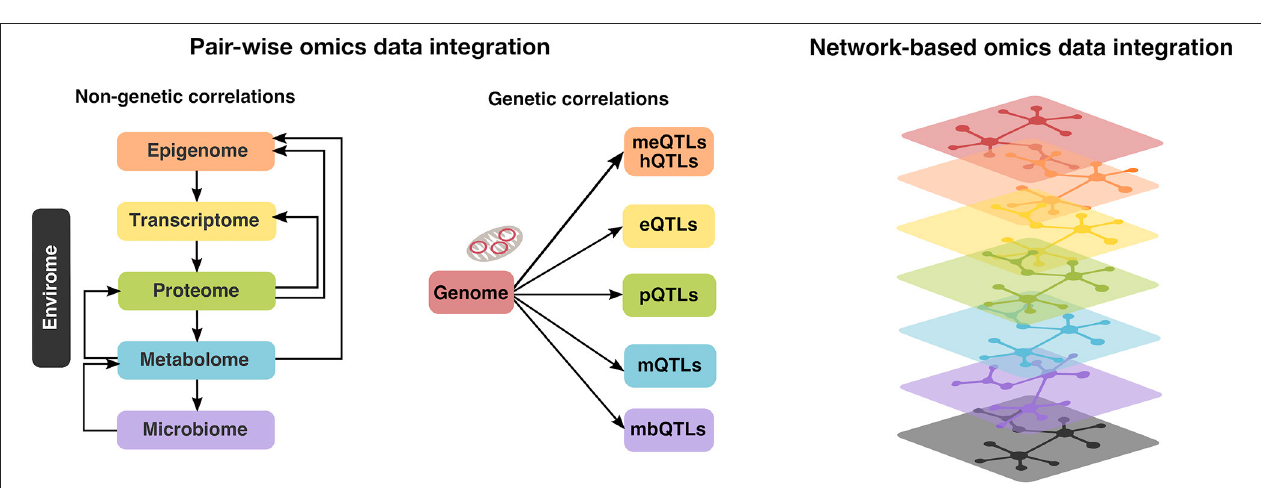
FIGURE 2 | Multi-omics (i.e., autosomal and mitochondrial genome, epigenome, transcriptome, proteome, metabolome, microbiome, and envirome) data integration can be conducted in two ways: pair-wise integrations, which can be further divided into non-genetic (left panel) and genetic correlations (middle panel). In the first case, one would examine the correlation patterns between the down-stream omics layers (e.g., metabolome and gut microbiome), whereas the second is achieved via the so called quantitative trait loci (QTL) mapping, linking genetic variation to methylation levels (meQTLs) or histone modifications (hQTLs), transcriptome (expression QTLs; eQTLs), protein (pQTLs), metabolite (mQTLs) or measures of microbiome (mbQTLs). Alternatively, multi-dimensional i.e., network-based integration approaches (right panel) exist, however their application in the context of CAD has so far been limited (